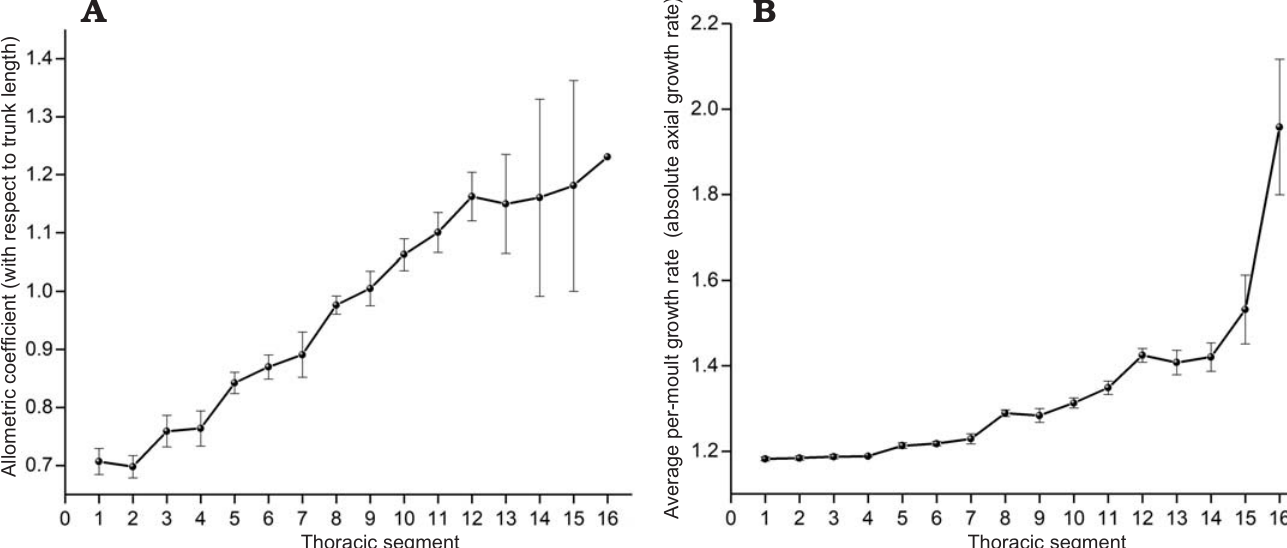
Fig. 10. Growth gradient in the trunk of Changaspis elongata Lee in Chien, 1961. A . Allometric coefficients of individual thoracic segments with respect to trunk length. B . Average per-moult growth rates of individual thoracic segments. Both exhibit significant increasing value from anterior to posterior (Spearman’s rank correlation test, n = 16, p A = 0.988, p B = 0.988). Bars are standard errors caused by structural deformation and measurement (not calcu- lable for TS16), n = 14 for TS1–4 and decreases from n = 13 to 2 for TS5–16, respectively. Abbreviation: TS1, section 1 thoracic